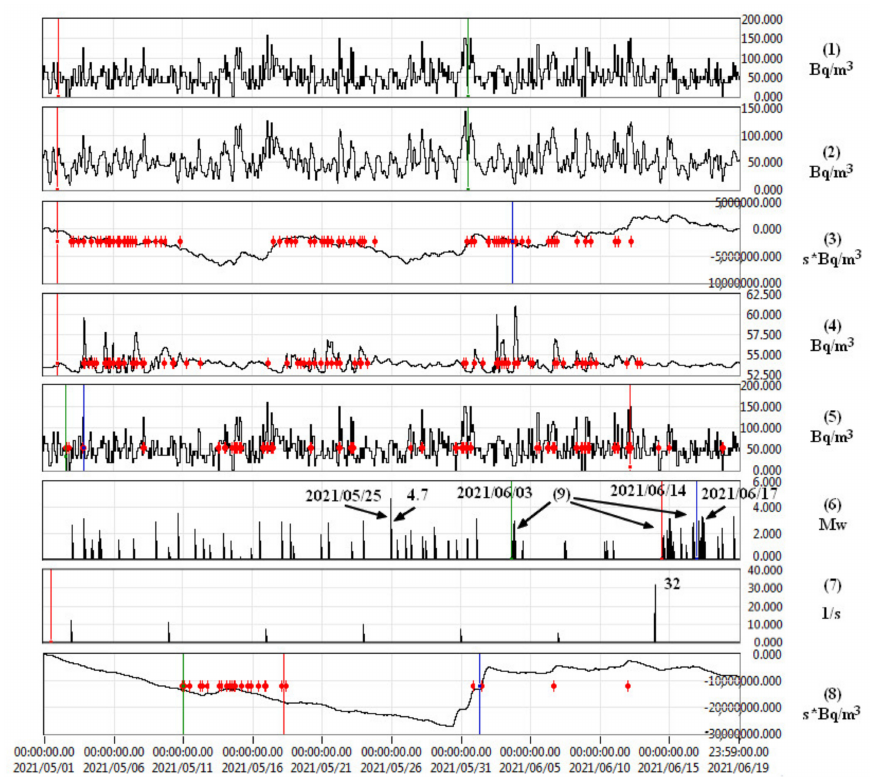
Figure 9. Analysis radon